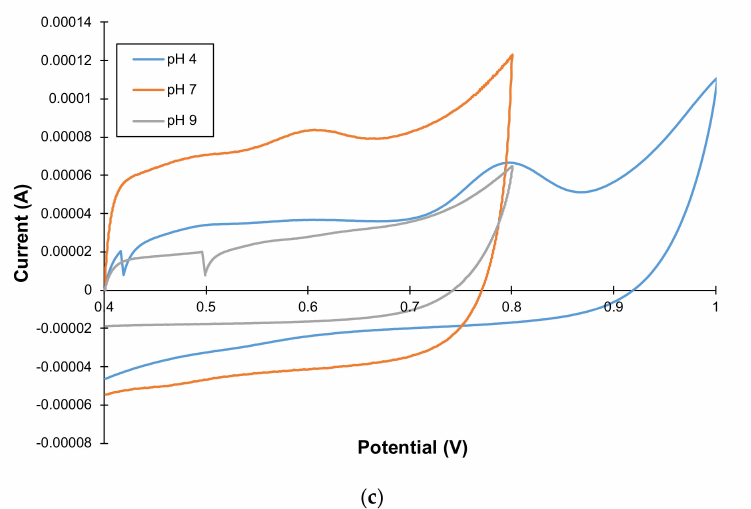
Figure 9. Anodic cyclic voltammograms of 100 µ M SFX using ( a ) bare GCE, ( b ) MWCNTs-CeO 2 @GCE, and ( c ) MWCNTs-Yb 2 O 3 @GCE sensors in different buffer aqueous solutions (acetate: pH = 4.0, phosphate: pH = 7.0, and borate: pH = 9.0) at 50 mV · s − 1 . Experimental conditions: counter electrode: Pt, reference electrode: Ag/AgCl; room temperature; stagnant solution; modified GCE sensor: 2 mg/mL MWCNTs and 0.5 mg/mL CeO 2 or Yb 2 O 3 and 10 µ L/mL of 5% Nafion